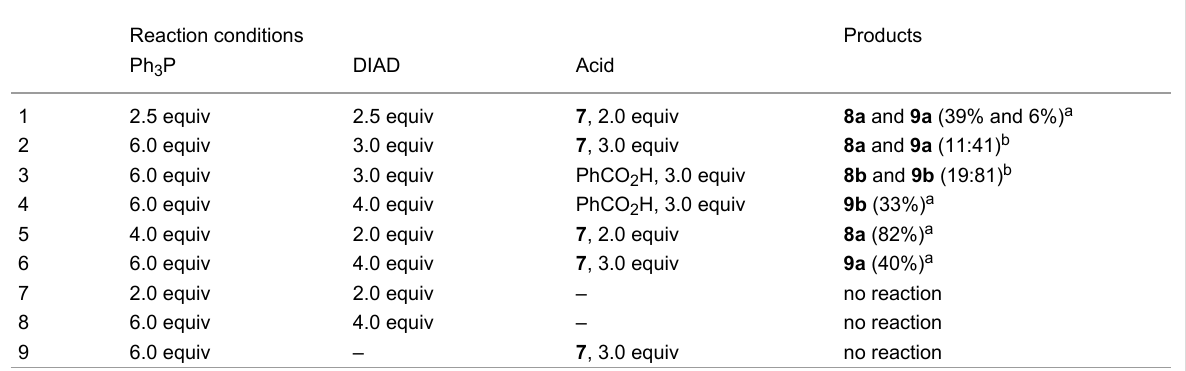
Table 1: Reaction conditions for optimization of